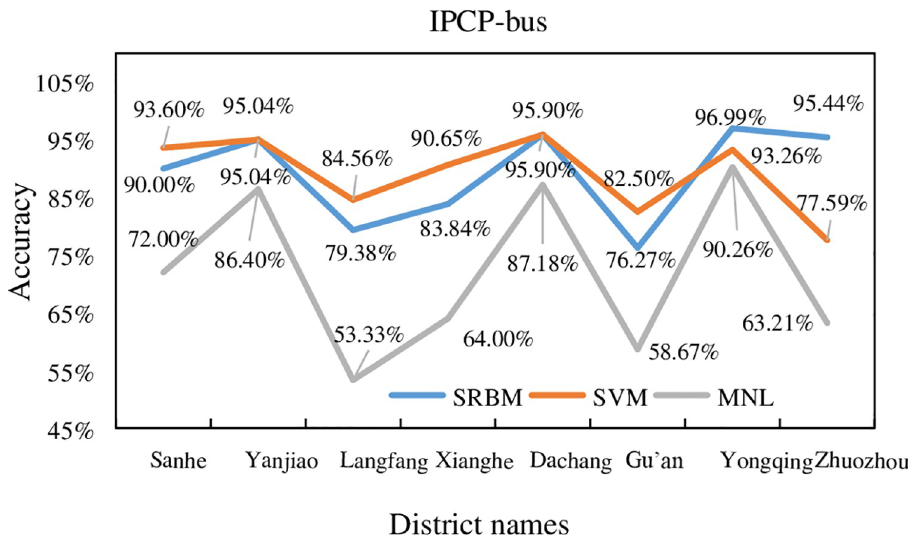
Fig 11. Bus accuracy of SRBM, SVM and MNL